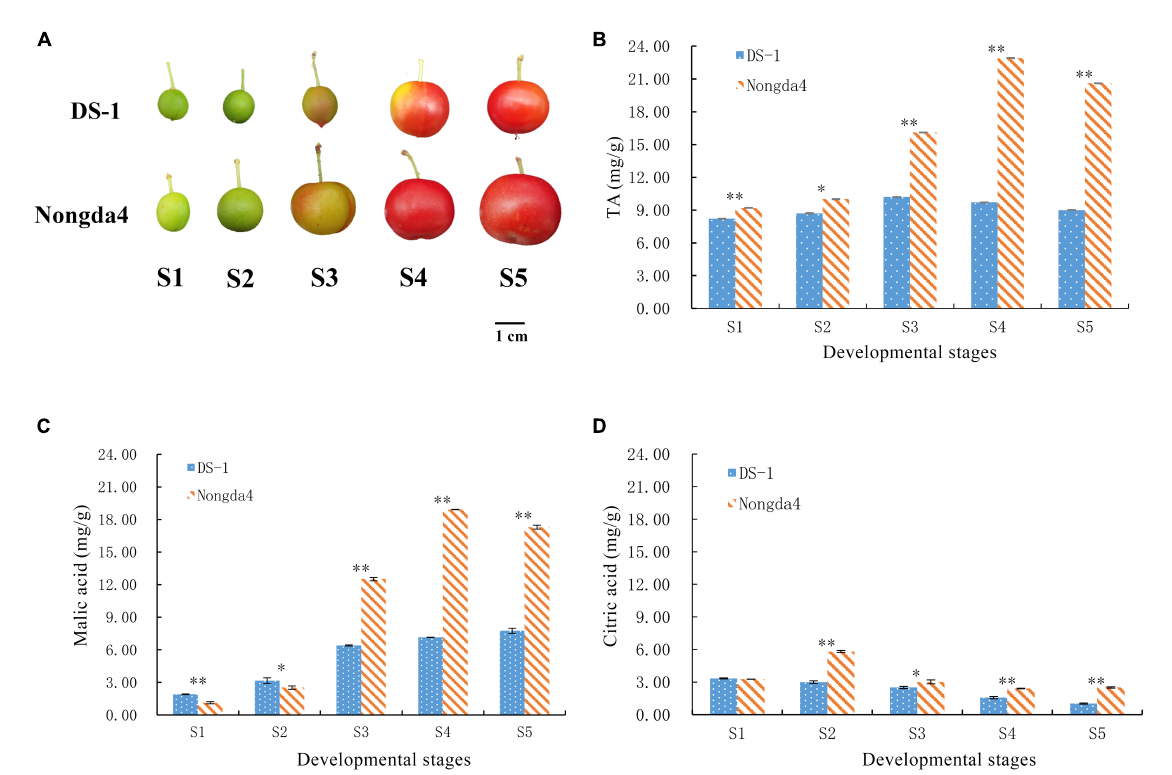
FIGURE1 Photograph of Chinese dwarf cherry fruits at different developmental stages (A) . S1, young fruit stage; S2, hard core stage; S3, turning stage; S4, coloring stage; S5, mature stage. Changes in TA (titratable acid) (B) , malic acid (C) , and citric acid (D) contents in Chinese dwarf cherry fruits during development. Data are means ± standard deviations of three biological repetitions. Error bars represent standard deviations of means. ∗ and ∗∗ indicate significant differences at P < 0.05 and < 0.01